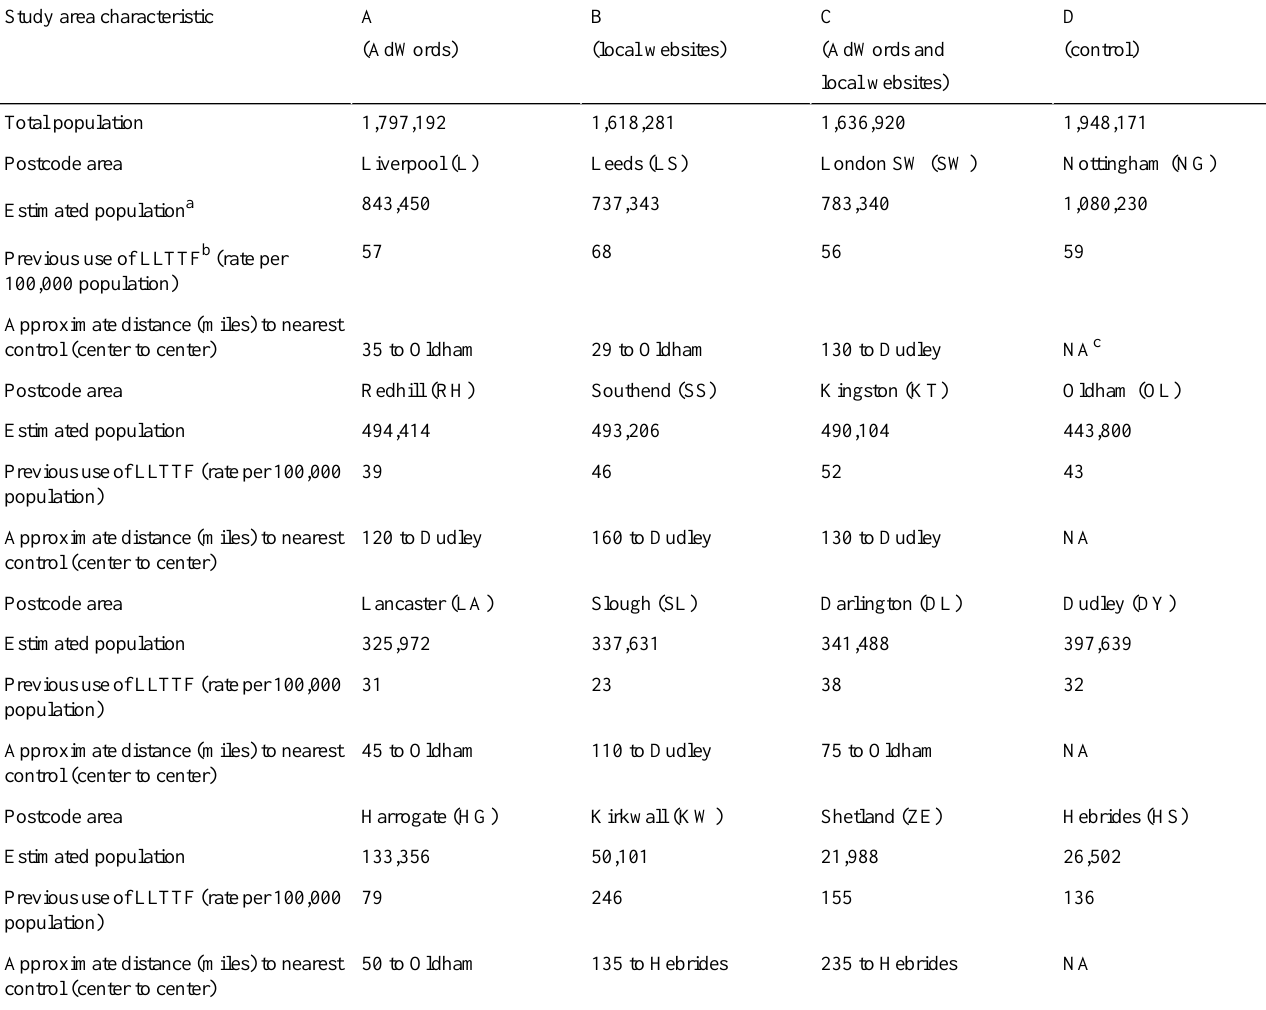
Table 1. Study areas, showing eight postcode areas (columns A and C) allocated to AdWords and eight postcode areas (columns B and D) allocated to another intervention and control (total population 7,000,564).